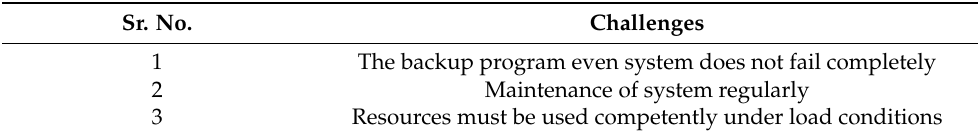
Table 18. Key challenges. Sr.